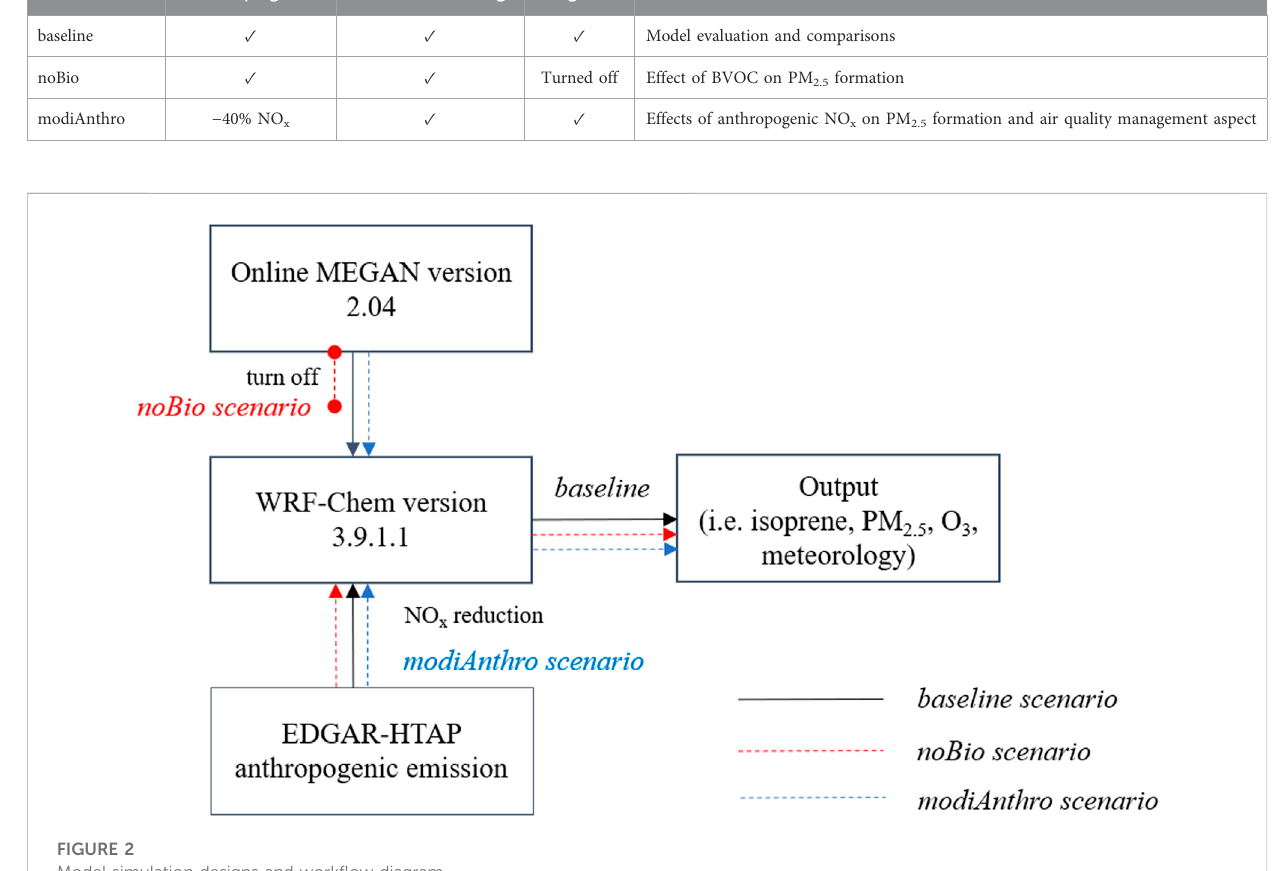
FIGURE 2 Model simulation designs and work fl ow